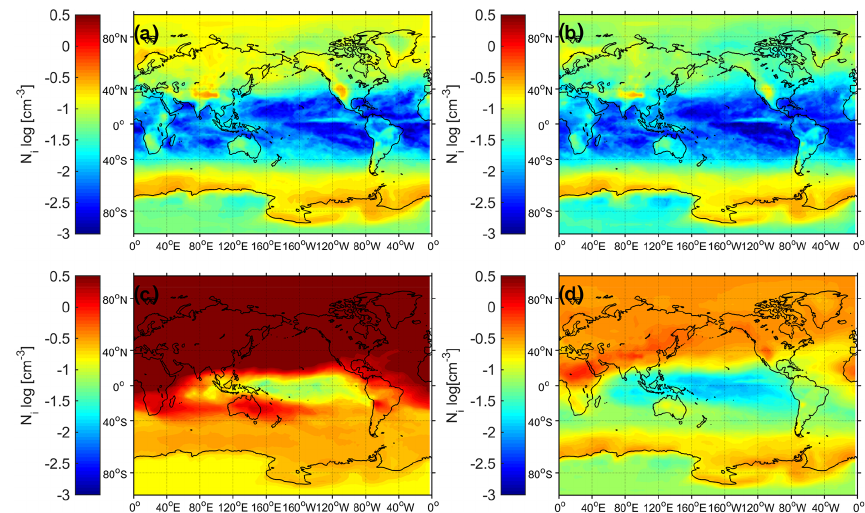
Figure 3. Annually averaged output nucleated ice crystal number, N i from the cirrus formation parameterization for (a) PDA08, (b) PDA13, (c) CNT, (d) AIDA nucleation